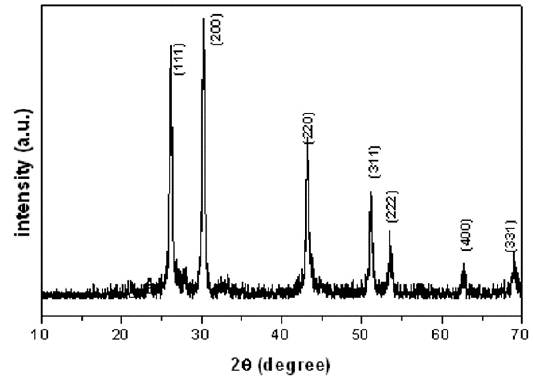
Figure 1. DRX pattern of the PbS powder.